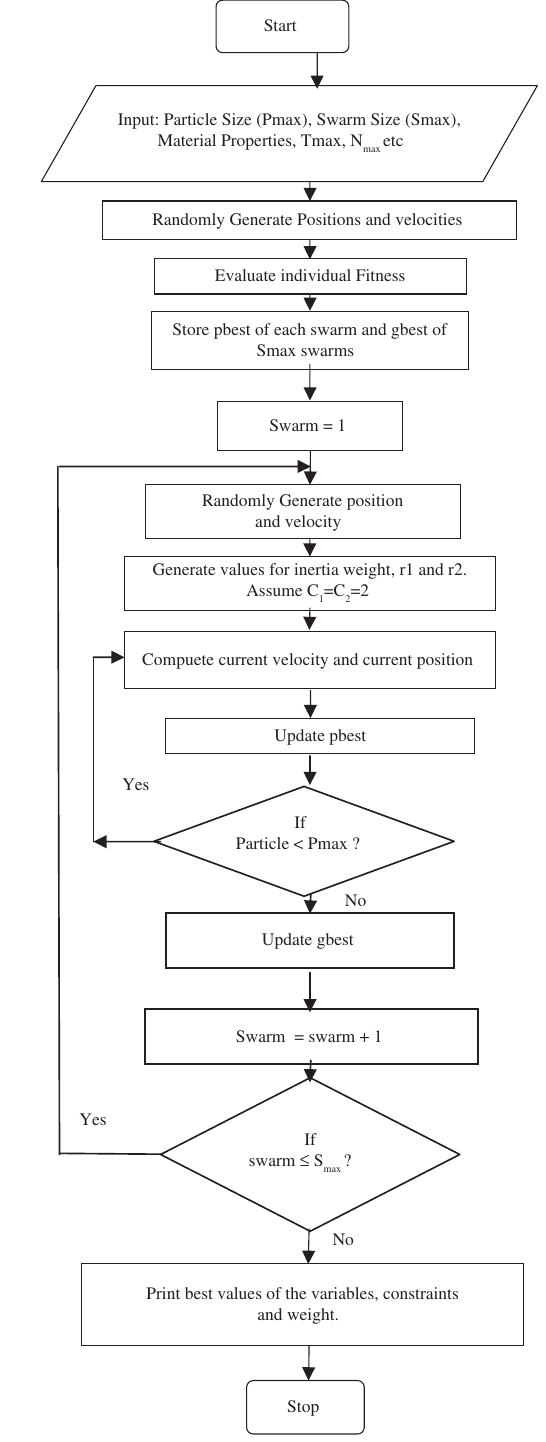
Figure 4. Flow chart of PSA based optimal design of composite drive